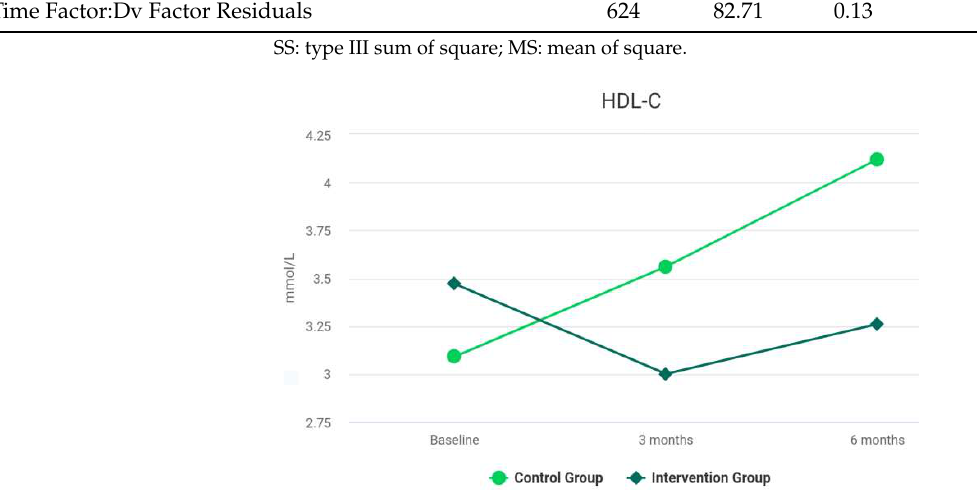
Figure 3. Results of LDL-C at baseline and during follow-up. Figure 4. Results of TG at baseline and during follow-up.